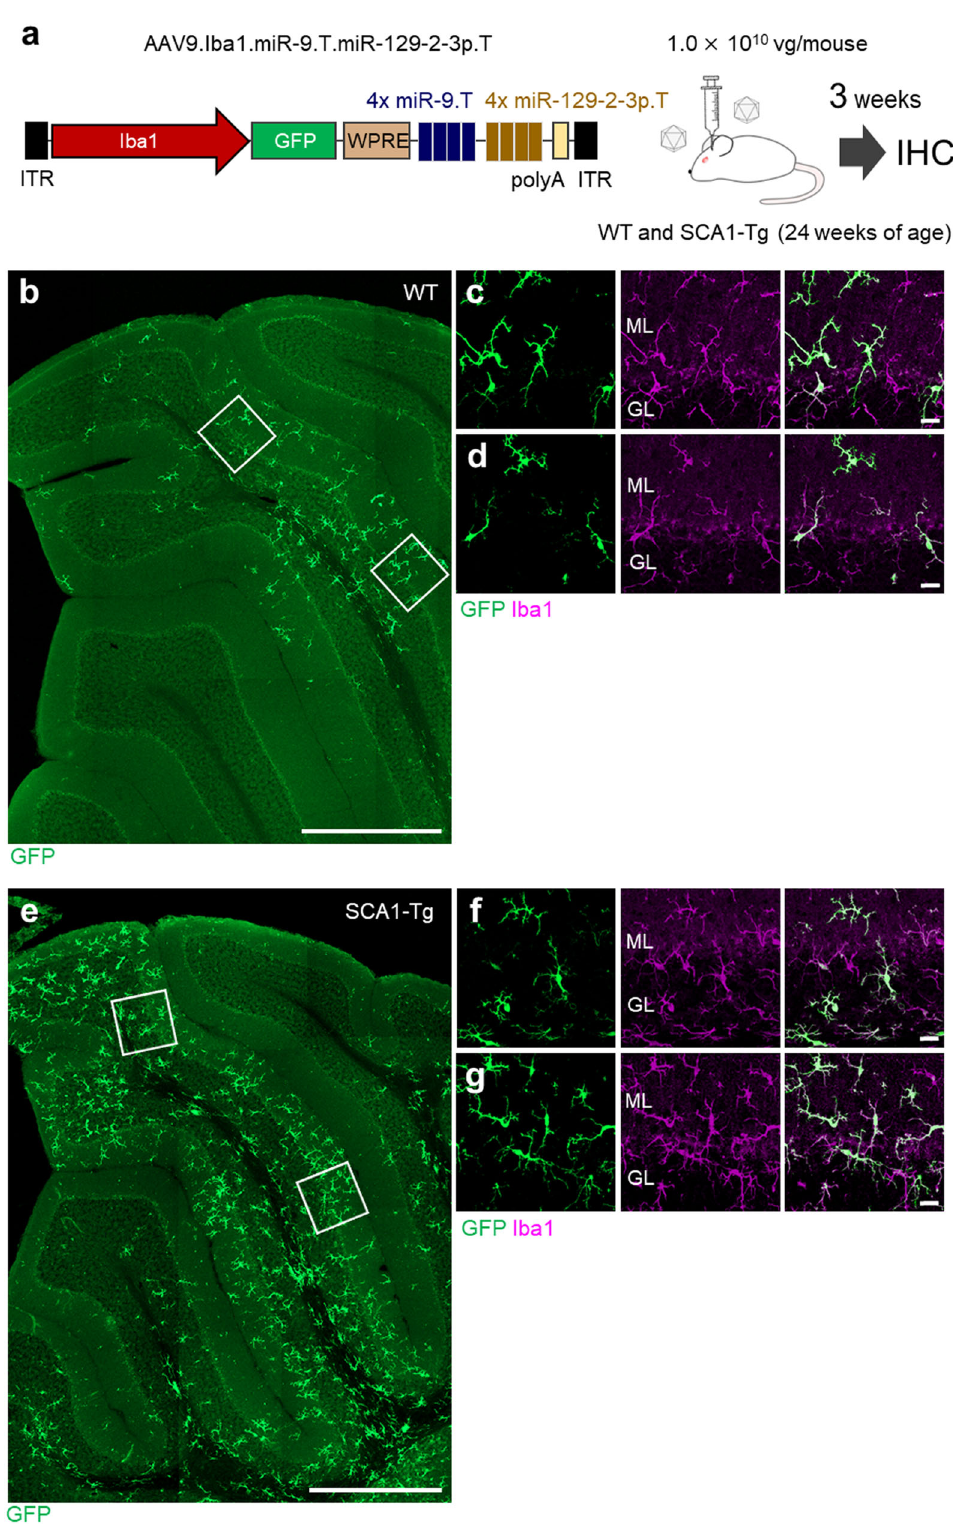
Fig. 5 Robust transduction of microglia in symptomatic SCA1-Tg mouse cerebellum. a AAV construct (AAV9.Iba1.miR-9.T.miR-129-2-3p.T) and schematic of the virus injection. AAV (dose: 1.0 × 10 10 vg/mouse) was injected into the wild-type and SCA1-Tg mouse cerebellum at 24 weeks of age. Three weeks after the viral injection, cerebellar sections were analyzed by immunohistochemistry. b – d GFP immuno fl uorescent image of the wild-type (WT) mouse cerebellum. e – g GFP immuno fl uorescent image of a sagittal section of the SCA1-Tg (B05) mouse cerebellum. Square regions in b and e were enlarged to c , d and f , g , respectively. Scale bars; 500 μ m ( b , e ) and 20 μ m ( c , d , f , g ). GL granule cell layer, ML molecular